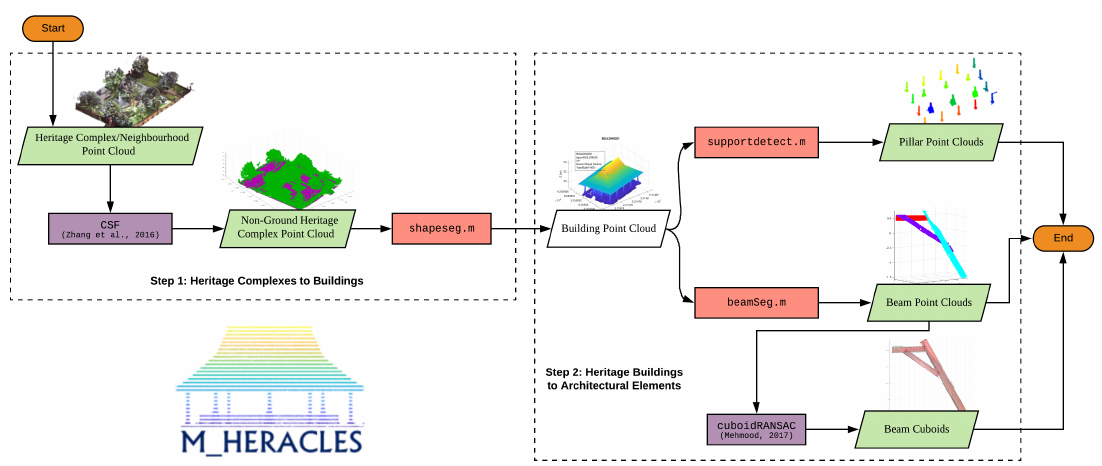
Figure 3. A general flowchart of the workflow within M_HERACLES. Step 1 consists of segmentation from the scale level of a neighborhood to that of individual buildings, while the Step 2 involves segmentation from a building’s scale level to that of architectural elements (pillars and beams). Violet rectangles denote the use of third party libraries; red rectangles denote the main functions developed in this study for the respective